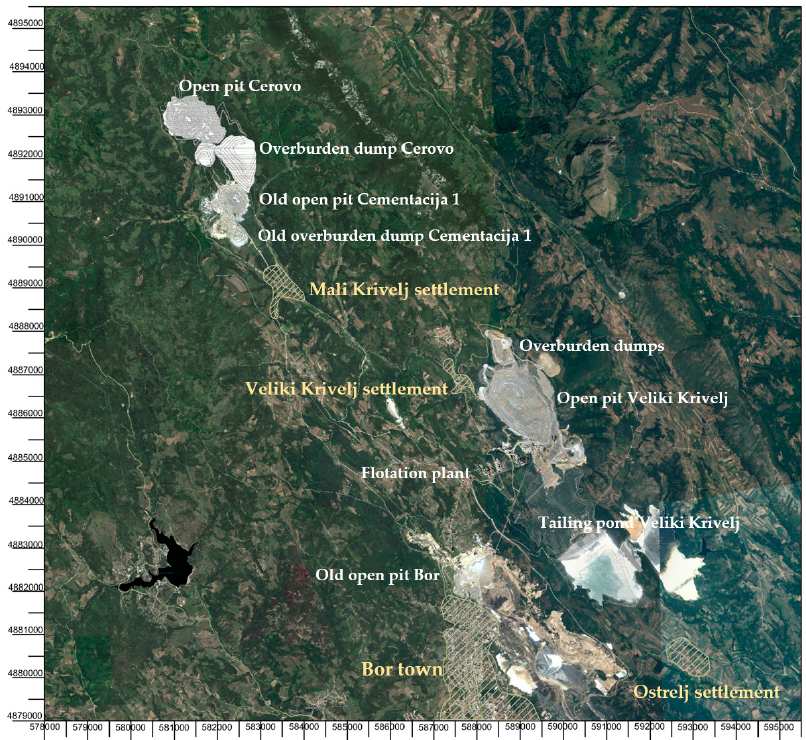
Figure 2. Locations of mining facilities in the area of the RTB Bor copper mine.